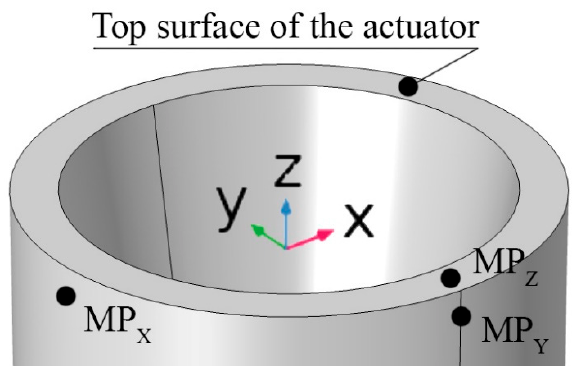
Figure 12. Schematics of displacement amplitude measurements in different planes; MP, measurement point.